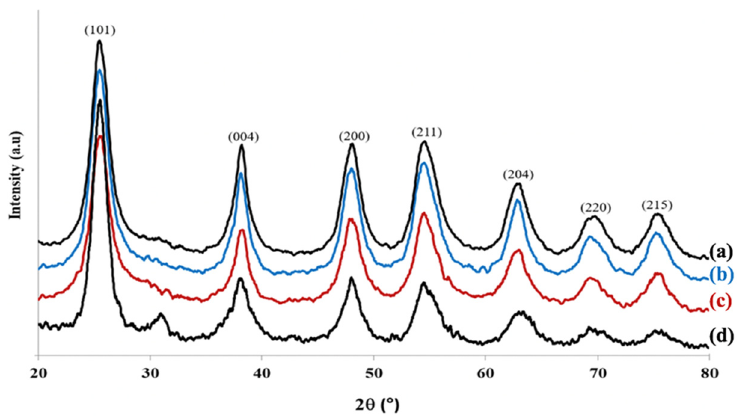
Figure 3. XRD patterns of Pd/TiO 2 _x catalysts: (a) x = 100; (b) x = 50; (c) x = 20; (d) Pd/TiO 2 _citrate free after drying at 70 °C for 24 h.